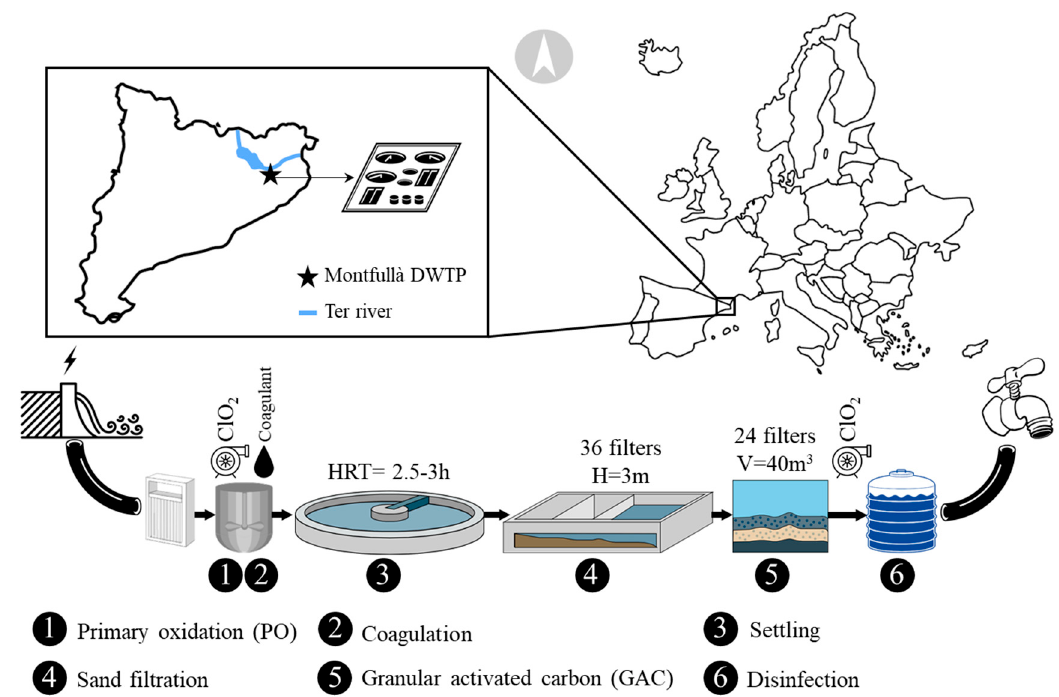
Figure 1. Montfullà drinking water treatment plant (DWTP) geographical location and treatment flow diagram. HRT, hydraulic retention time; H, height; V, volume. Table 1. Main characteristics of the Montfullà DWTP raw water parameters (1 January 2014–31 December 2018).